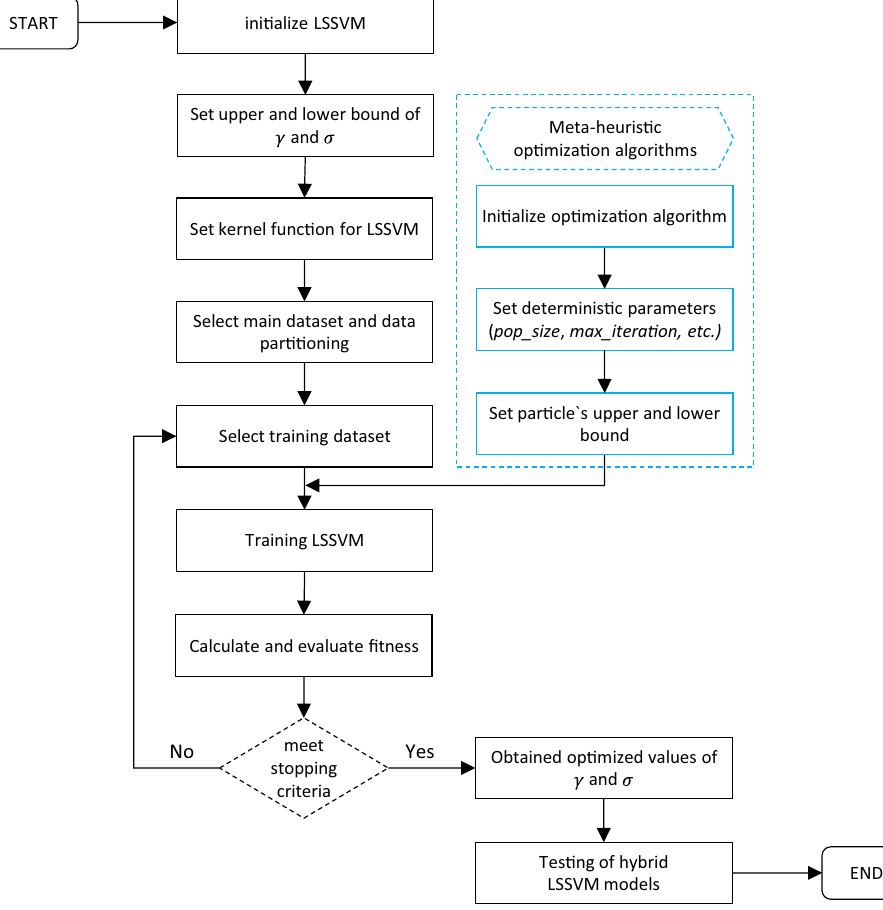
Figure 1. A flowchart showing the steps of hybrid LSSVM